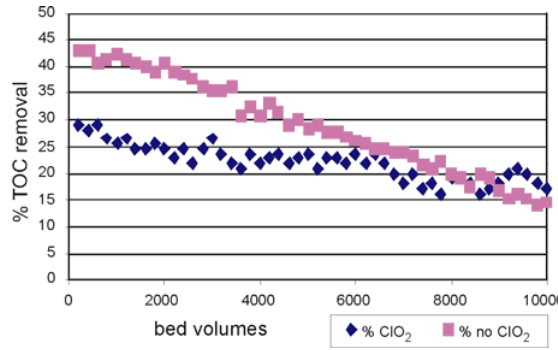
Fig. 4a. TOC removal in the GAC vegetal column vs . time in Fortore pilot plant